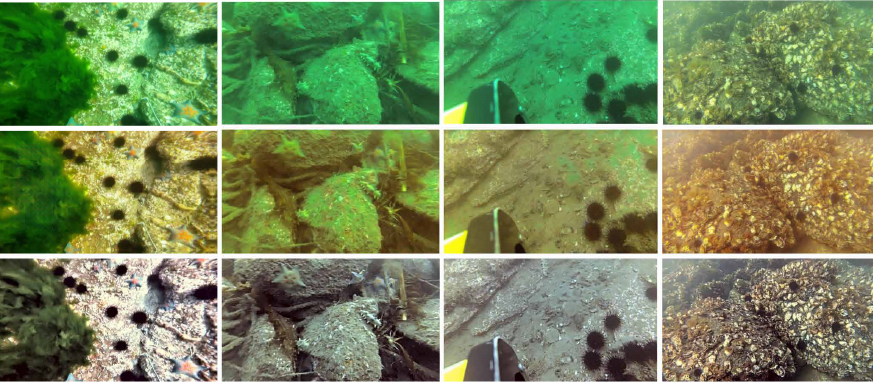
Figure 9. Enhanced samples of images in the URPC2021 dataset. The first row shows the original images; the second row displays the samples enhanced by the FUnIE-GAN method; the third row is the samples enhanced by MLLE.